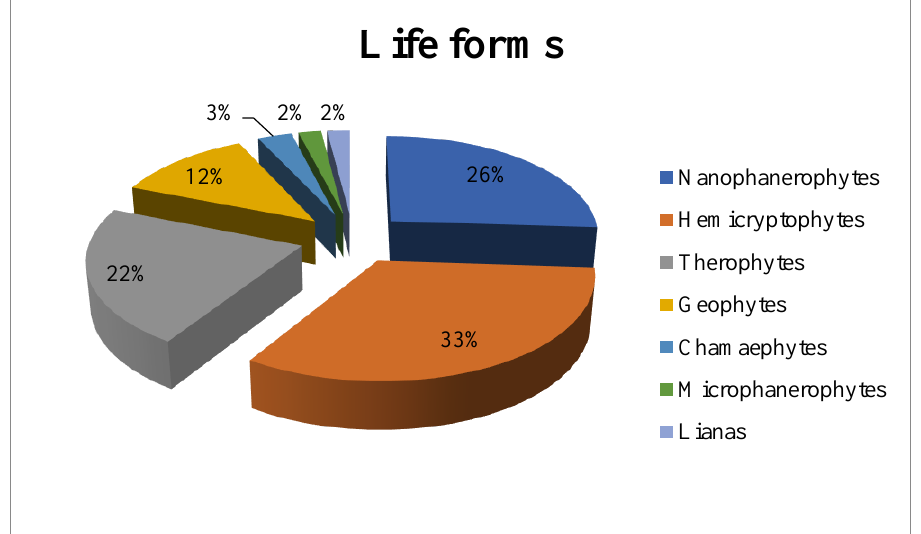
Figure 2. Life-form classes of the plant species recorded in the understory vegetation of oak-dominated forests of Swat, Pakistan.